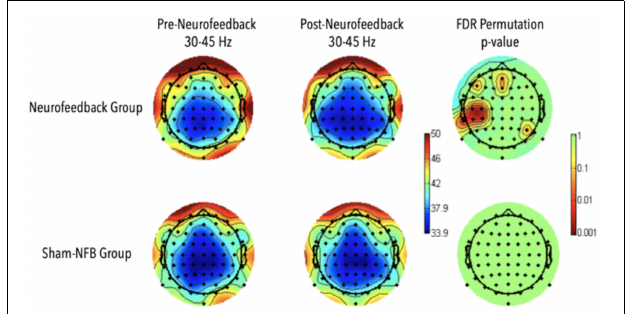
FIGURE 8 | Results for Adaptive Neurofeedback (top) and sham (bottom) groups for gamma-power during the 2-back task, before (left) and after (middle) the adaptive neurofeedback sessions. The color bar on the right represents the statistical significance of the difference pre and post